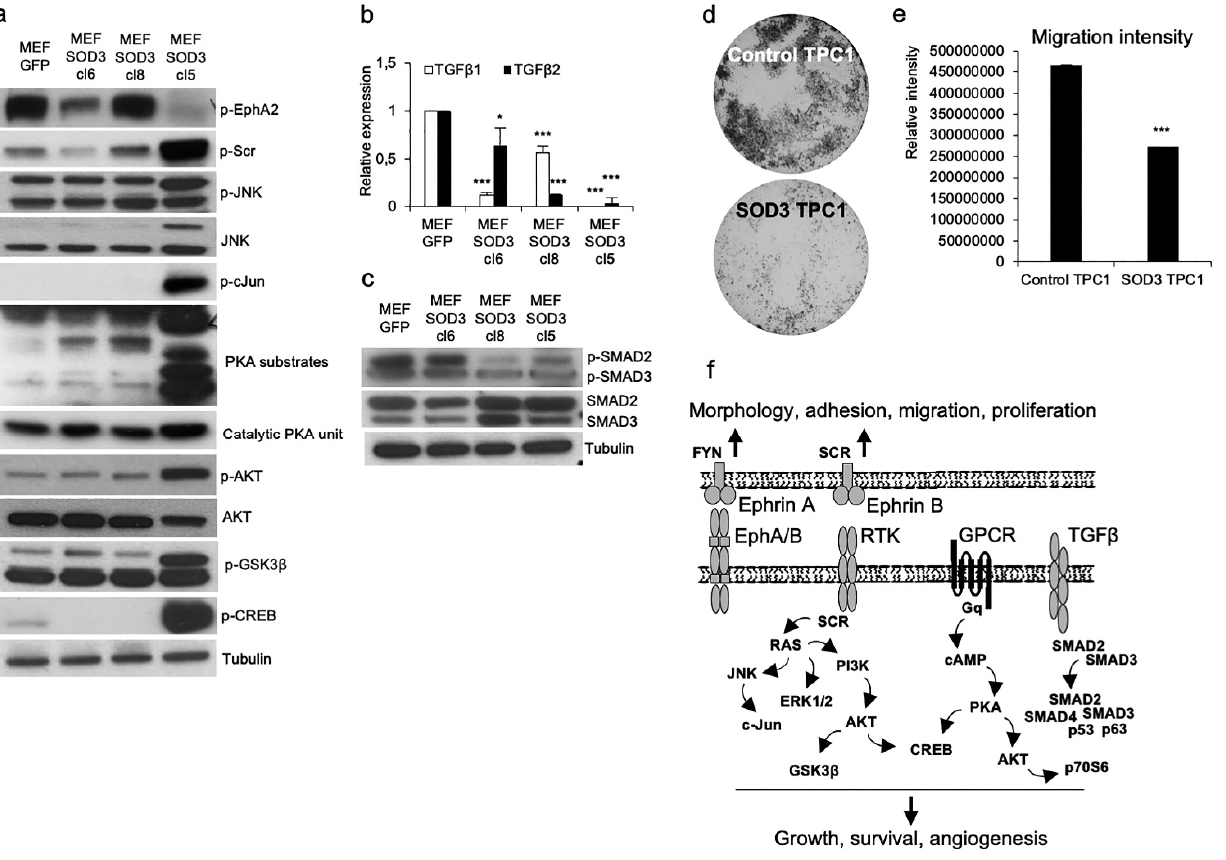
Figure 5. Activation analysis of specific kinases. ( a ) MEF SOD3 cl5 demonstrated the highest phosphorylation of SRC, cJUN, AKT, and CREB. In addition, we observed a markedly increased activation of PKA substrates and decrease activation of EphA2 in cl5. ( b ) The tgf β mRNA analysis demonstrated significantly decreased tgf β 1 and tgf β 2 expression in MEF SOD3 cl6 ( p < 0.001 and p < 0.05, respectively), MEF SOD3 cl8 ( p < 0.001 and p < 0.001, respectively), and MEF SOD3 cl5 ( p < 0.001 and p < 0.001, respectively). ( c ) Western blot analysis for the TGF β downstream kinases SMAD2 and SMAD3. Phosphorylation of SMAD2 and SMAD3 was decreased in MEF SOD3 cl8 and cl5 as compared to the MEF GFP control. ( d ) TPC1 Matrigel migration analysis. Control plasmid-transfected TPC1 cells demonstrated higher migration levels than SOD3-transfected cells. ( e ) The intensity measurements of the migration images show a significantly ( p < 0.001) decreased migration in SOD3 chambers. ( f ) Putative schematic presentation of the signaling pathways regulated by SOD3. The p -values are * p < 0.05 and *** p < 0.001.